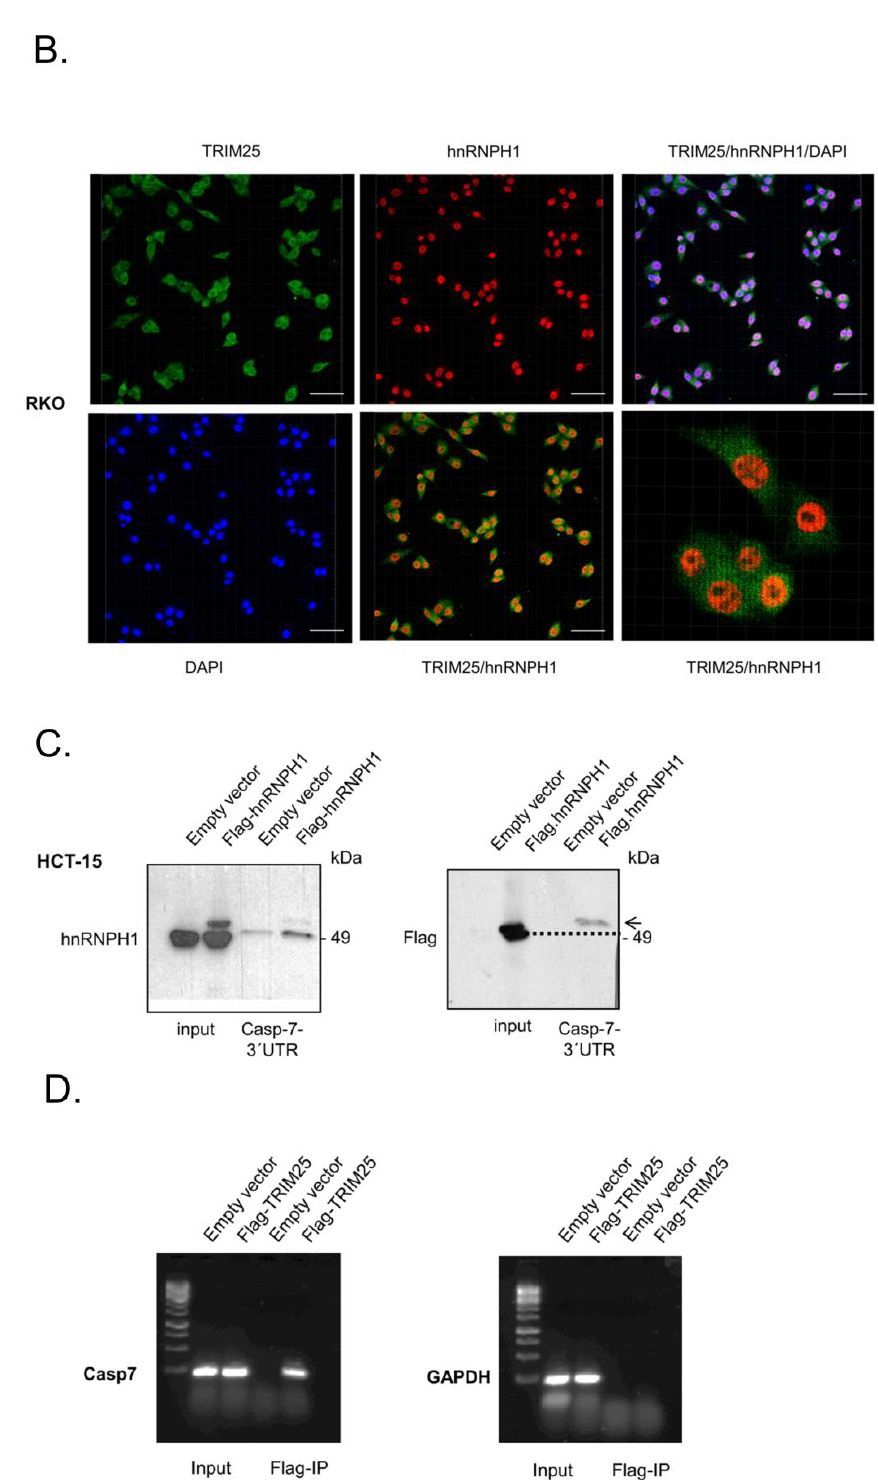
Figure 4. Binding of TRIM25 and hnRNPH1 to the 3 (cid:48) UTR of caspase-7 mRNA. ( A ) Biotin pulldown assay demonstrating different binding affinities of TRIM25 and hnRNPH1 to the 3 (cid:48) UTR of caspase-7. Biotinylated transcripts (20 µ g) encompassing putative binding sites for hnRNPH1 (x) and TRIM25 (Y) within the 3 (cid:48) UTR of caspase-7 as depicted on the right panel were incubated with 300 µ g of nuclear (n.) or cytoplasmic (c.) cell extracts from RKO cells. Subsequently, TRIM25 and hnRNPH1 binding to the pulldown material as well as input levels (input) was monitored by immunoblotting. Lamin A was used as a marker for cell nuclei. ( B ) Intracellular TRIM25 (green) and hnRNPH1 (red) in RKO cells were visualized by confocal microscopy. Nuclei of RKO cells were